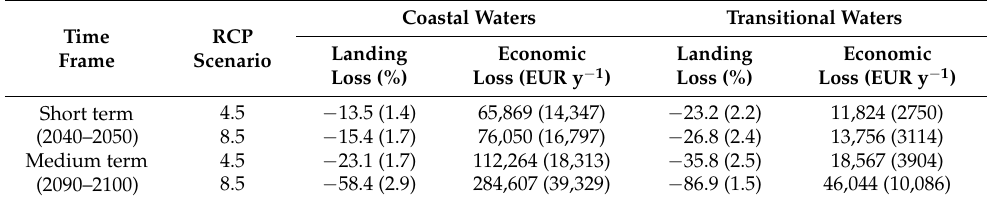
Table 5. Estimated annual loss of landings—expressed as % of the average annual landings in the three-year period 2017–2019—and estimated economic loss (EUR y − 1 ) resulting from the expected decrease in landings (only the 17 species analyzed in this study were considered). In brackets the standard error of the estimates.